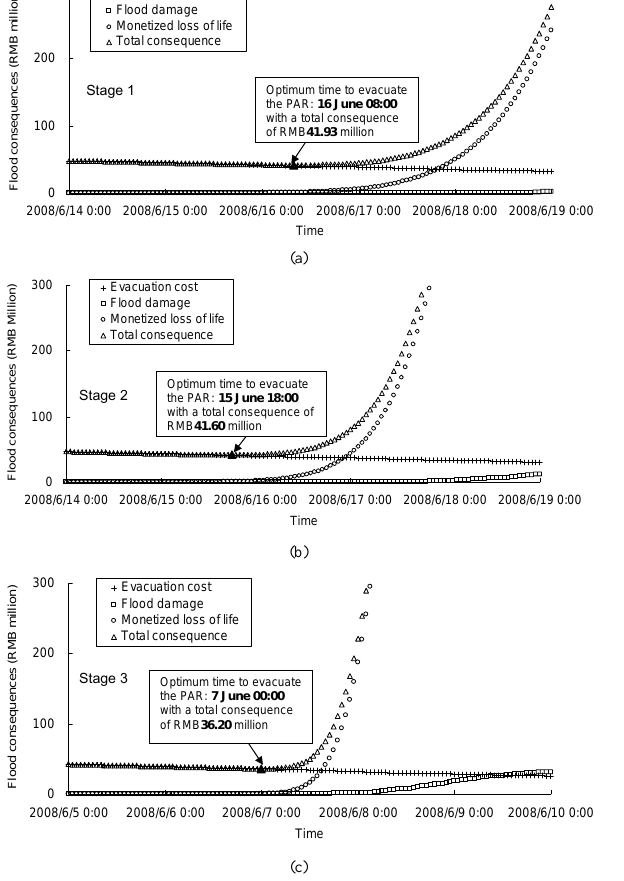
Optimum time to evacuate the PAR: 19 June 10:00 with a total consequence of RMB 370.10 million